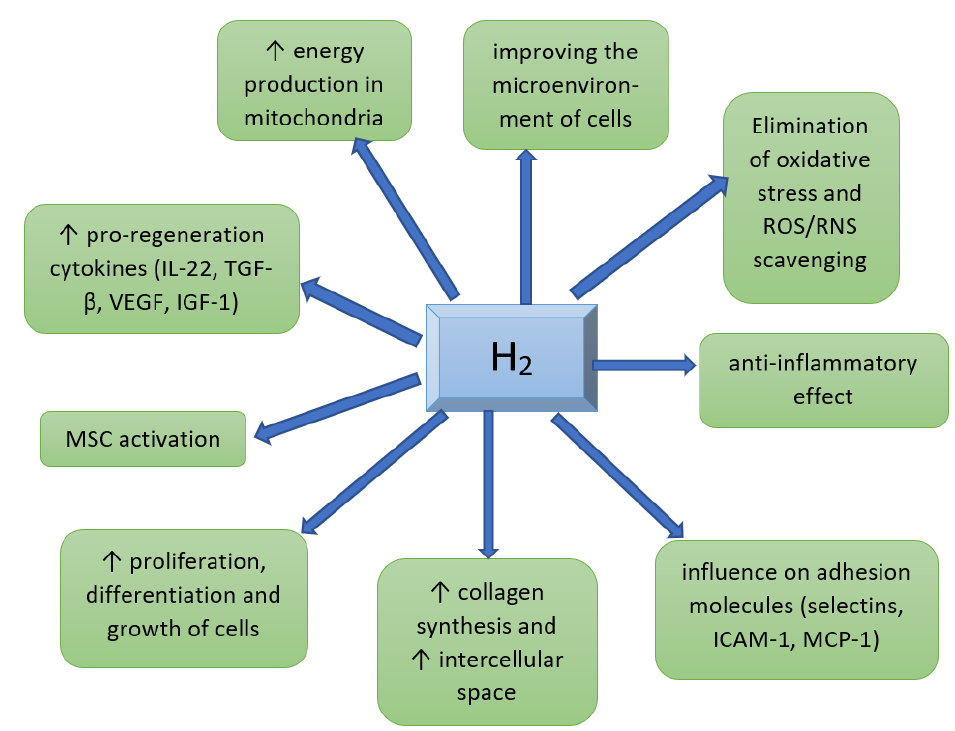
Figure 7. The influence of molecular hydrogen on tissue regeneration. The figure illustrates the effects of molecular hydrogen, potentially significant for stimulating the regeneration and differentiation of stem cells. Abbreviations: IL–interleukin, TGF–tumor growth factor, ROS–reactive